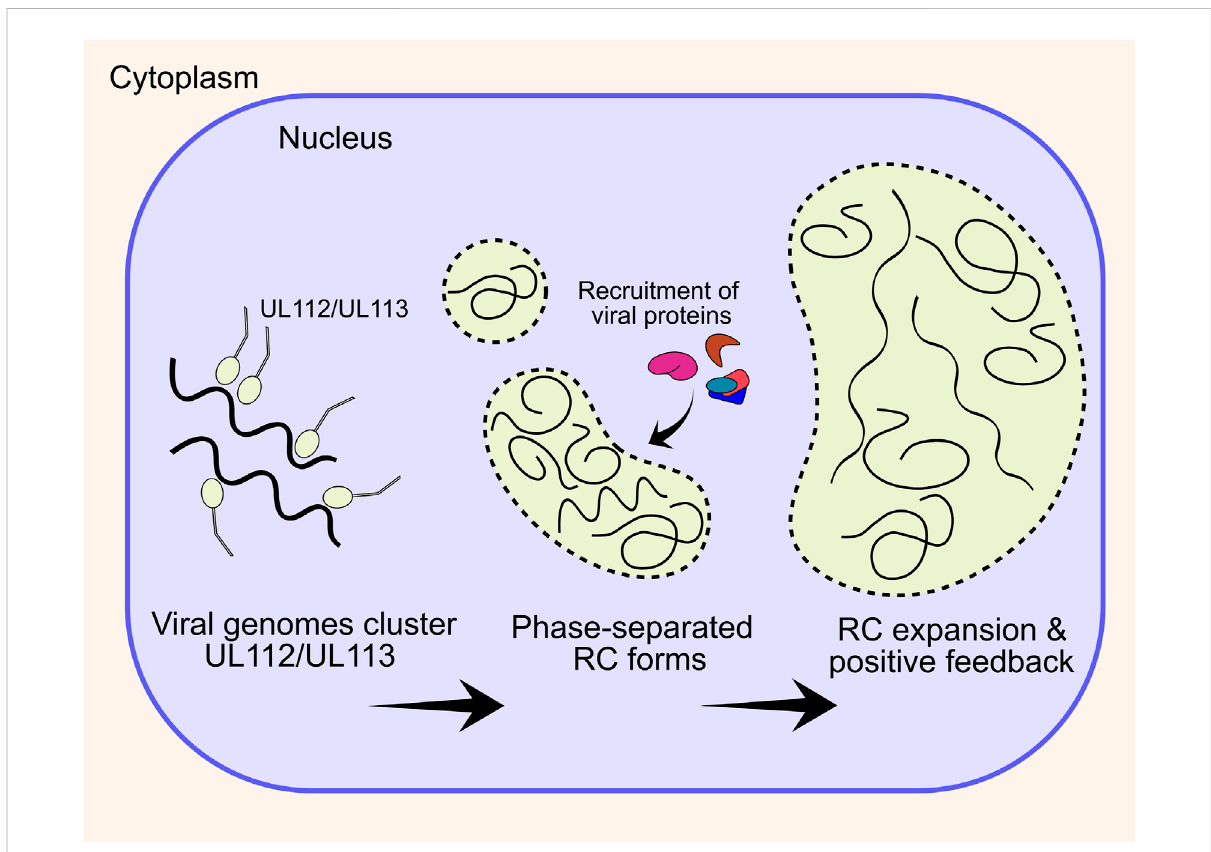
FIGURE 3 HCMV forms an intranuclear replication compartment for viral DNA replication and transcription. The UL112/UL113 proteins coalesce around viral genomes and together induce a phase separation. Nuclear viral proteins, including DNA replication machinery preferentially localises to the phase separated compartment, enhancing DNA replication and creating positive feedback. Over the course of infection, multiple small pre-RCs expand and coalesce into a single large structure that occupies most of the nuclear volume. RC, replication